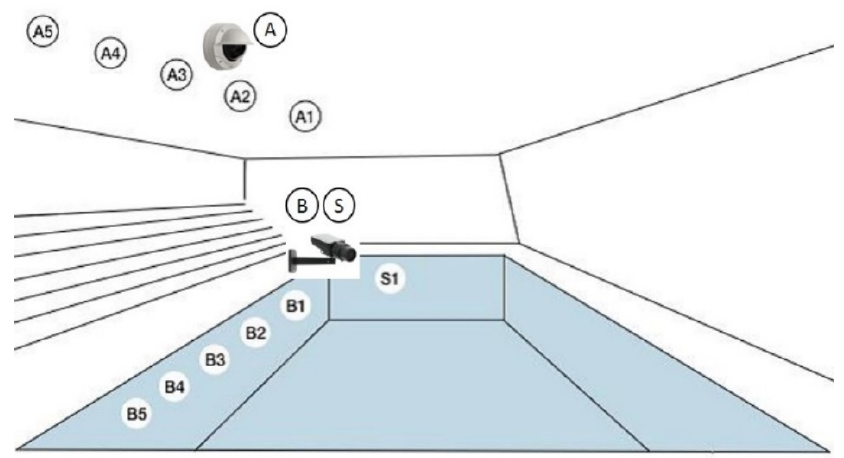
Figure 1. Placement of the video cameras. Note: A—The above water cameras (locations A1–A5), B and S—the underwater cameras, placed behind windows (locations B1–B5 and S1 placed beneath the starting block).